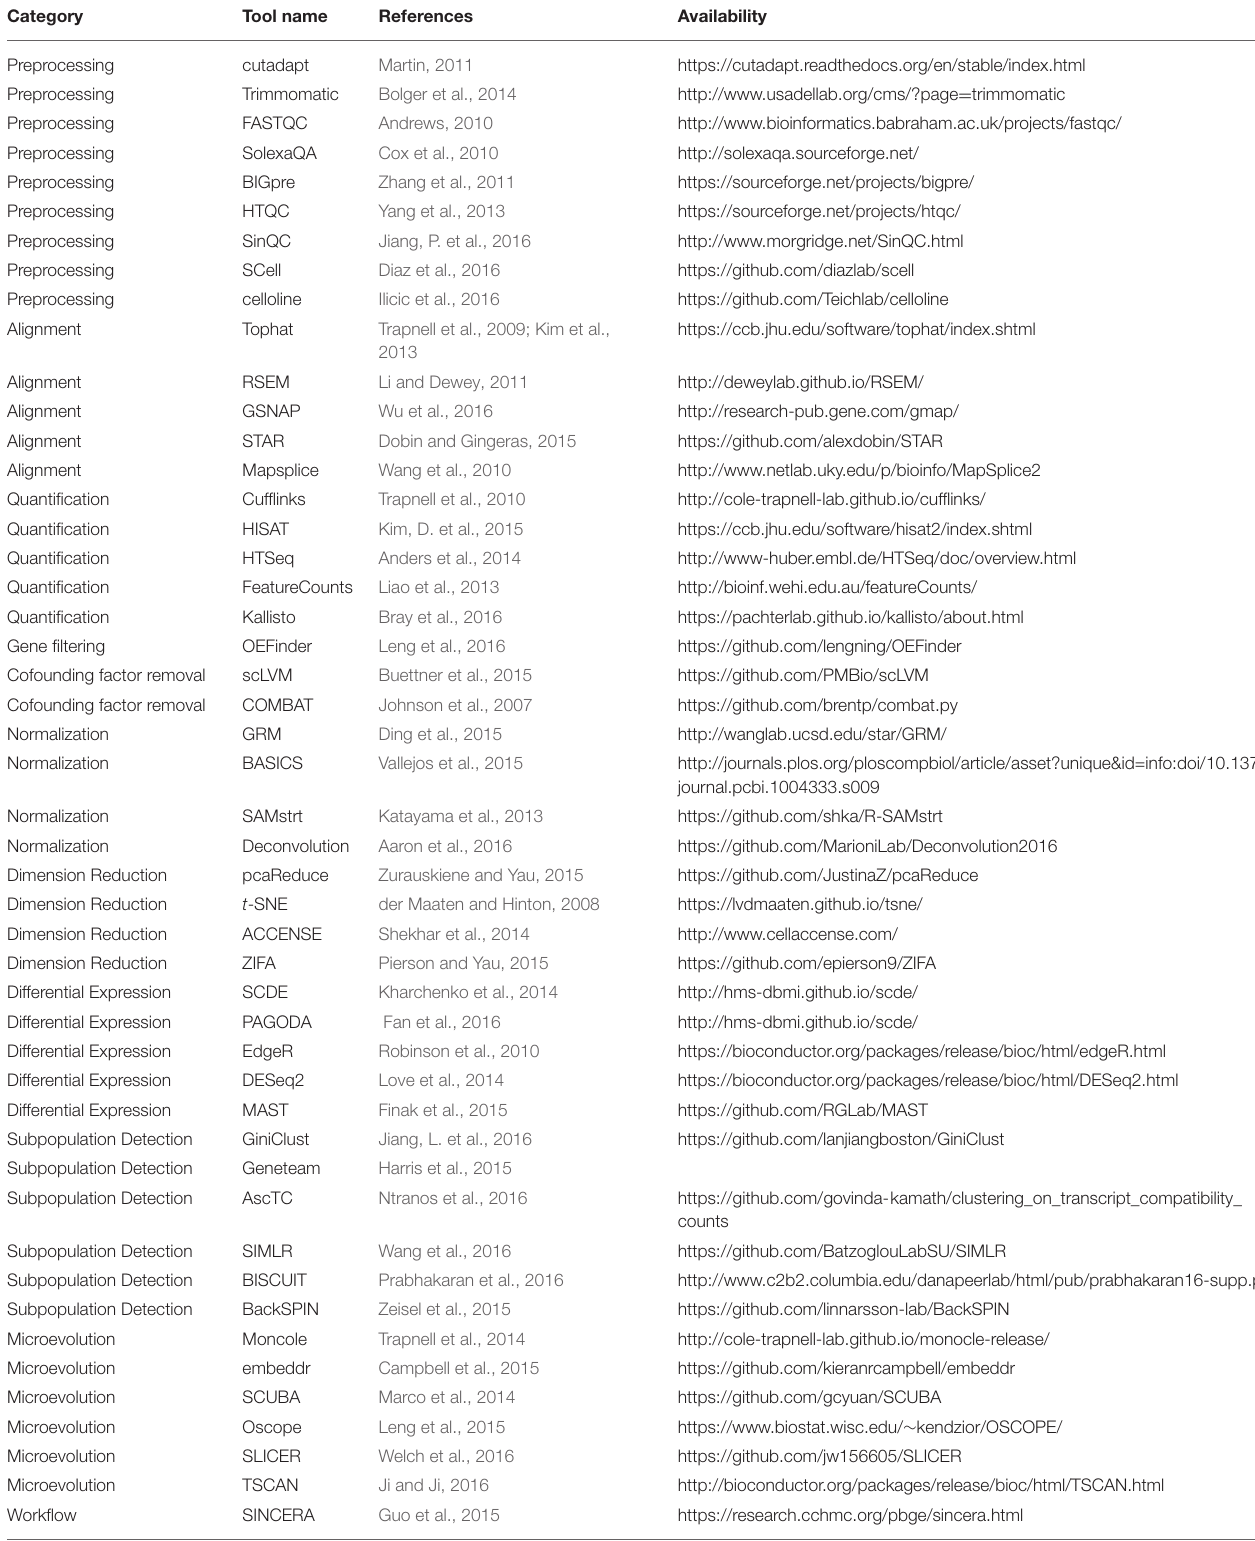
TABLE 1 | List of single-cell analytical tools mentioned in this